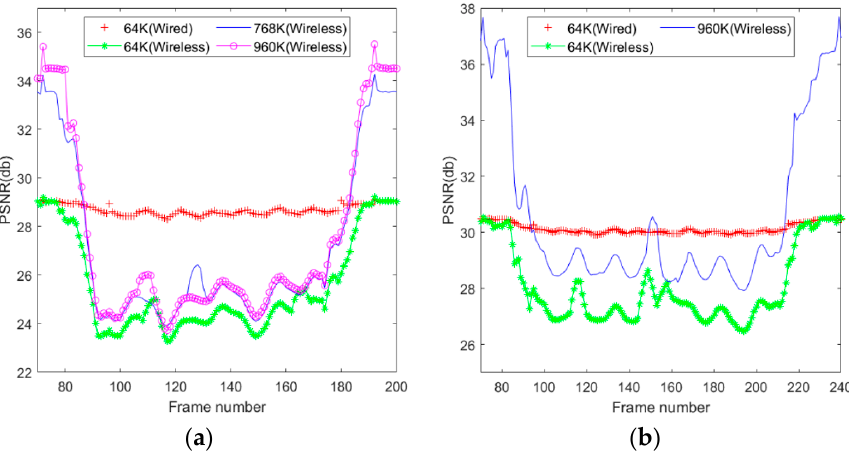
Figure 9 . ( a ) In scenario 38, the moving object occupies a large area and moving at higher speed. When a moving object appears in the video, the PSNR value is reduced significantly. When we input this scenario into our model, we obtain an estimated coding bitrate of 768 Kbps. See the blue ( − ) line. Please note that there is a significant gap between the blue ( − ) and red lines ( + ). The red line is our experimental goal. In theory, it should fall in 960 Kbps, even if we set the limit to 1 Mbps. The magenta (-o-) represents a coding rate of 960 Kbps and shows that most of its pattern overlaps the 768Kbps coding rate result. The proposed model uses the average PSNR value for comparison. ( b ) The area occupied by the moving object is a little bigger than that used in (a) but the object is moving at slower speed. The gap shown between the blue ( − ) and red ( + ) line is much smaller than